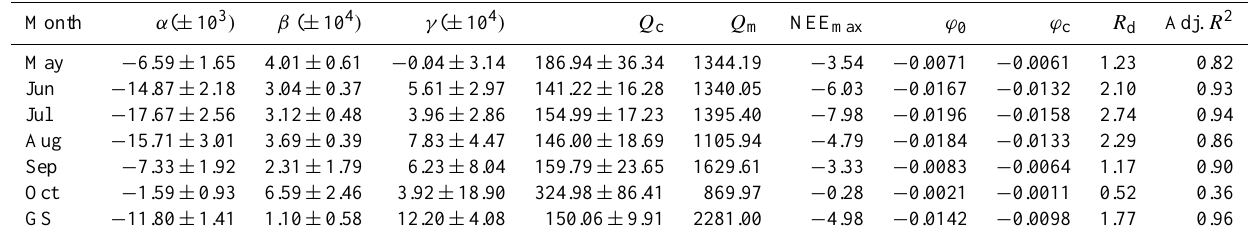
Table 1. Parameter values describing the response of daytime NEE to incident PAR for each month and the entire growing season (GS). Month